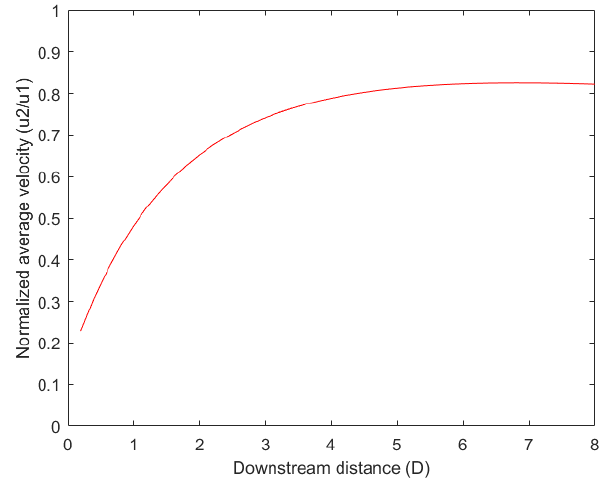
Figure 4. Normalized average velocity profile for a selected wind turbine.